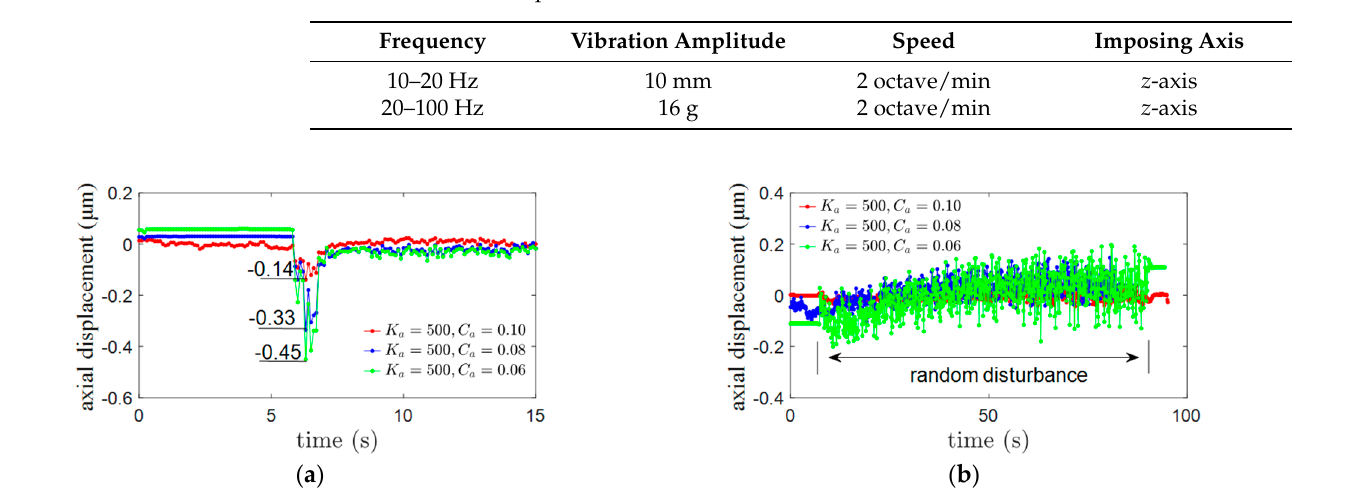
Table 2. The sine − swept vibration source.